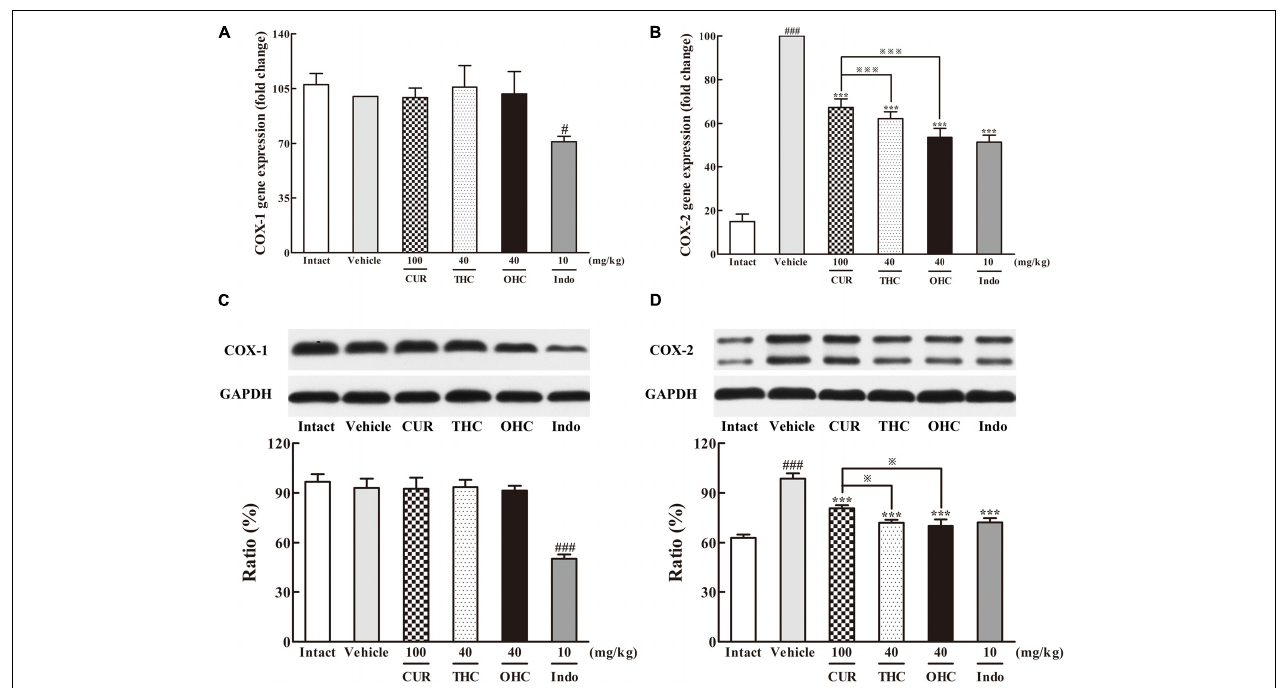
FIGURE 5 | Effects of THC and OHC on the mRNA (A,B) and protein (C,D) expressions of COX-1 and COX-2 in the carrageenan-induced mouse paw edema. After administration with THC (40 mg/kg, i.g.), OHC (40 mg/kg, i.g.) or CUR (100 mg/kg, i.g.) for 7 days, the hind paws were removed and isolated with TRIzol Reagent for analysis of mRNA expression of COX-1 and COX-2. Other hind paws were removed and homogenized in the lysis buffer, and then the protein extracts of hind paws were transferred to polyvinyl difluoride (PVDF) membranes and analyzed by Western blot. β -Actin was employed as the control for PCR. GAPDH was employed as loading control for Western blot. Data were expressed as means ± S.E.M. ( n = 3), # p < 0.05, ### p < 0.001 vs. the intact control; ∗∗∗ p < 0.001 vs. the vehicle control; ※ p < 0.001 vs. the CUR group. Significant differences between groups were determined by ANOVA and Dunnett’s post hoc test.